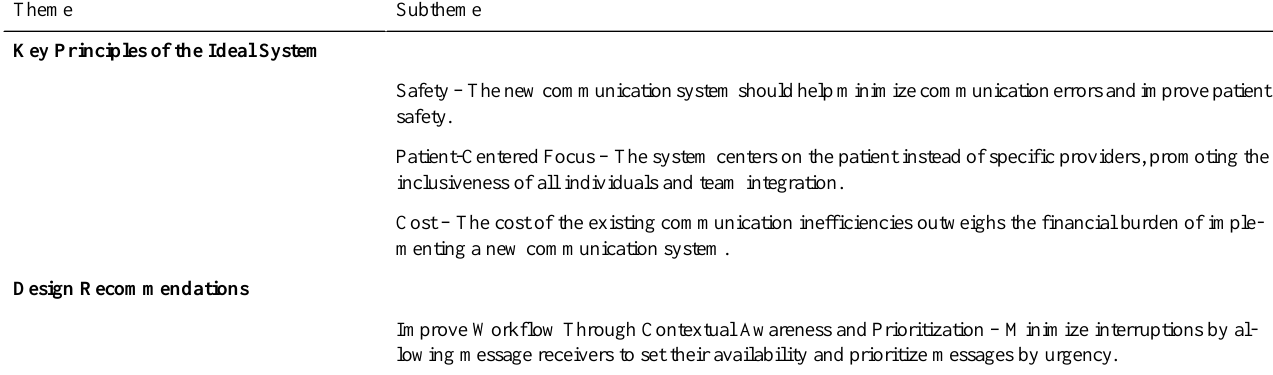
Table 1. Summary of major themes for design recommendations of an ideal communication system and recommendations for future